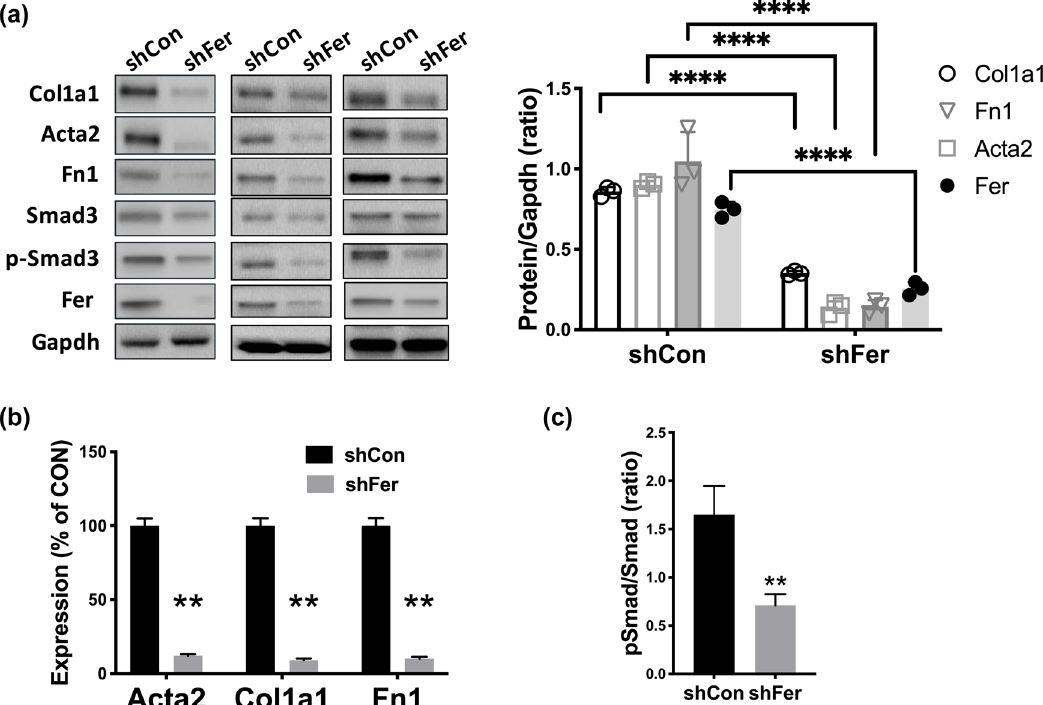
Figure 2: Silencing Fer ameliorates RF. Rat renal fi broblast cells NRK - 49F were treated with control and shRNA targeting Fer. ( a ) Protein level, ( b ) mRNA level of fi brosis - associated genes, and ( c ) phospho ( p )- Smad3 ratio calculated by the p - Smad3 level normalized to the total Smad3 densitometry level, all detected at 48 h after transfection ( * P < 0.05; ** P < 0.01 )